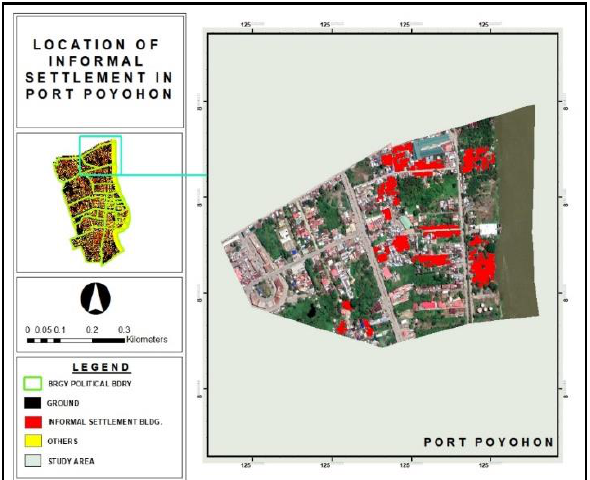
Figure 9. Informal Settlement in Brgy. Ong Yiu